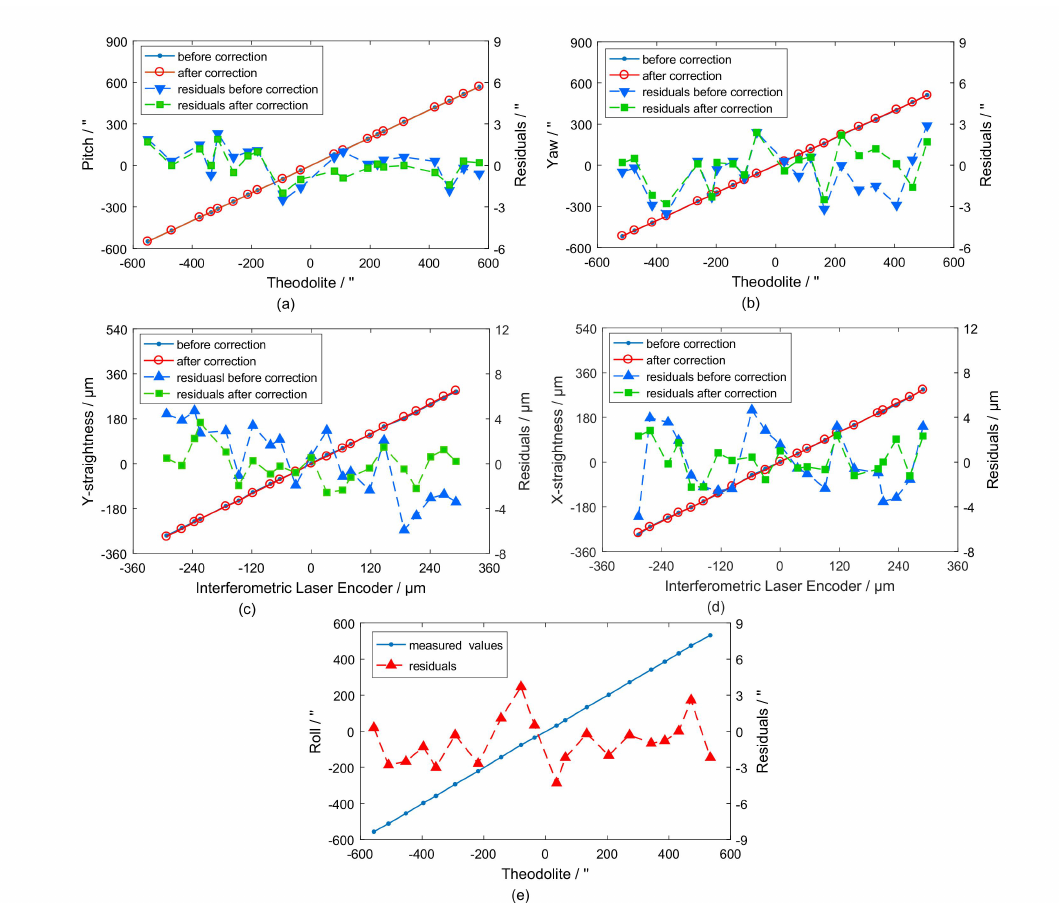
Figure 11. Results of the comparison experiments. ( a ) Pitch. ( b ) Yaw. ( c ) Vertical straightness. ( d ) Horizontal straightness. ( e )